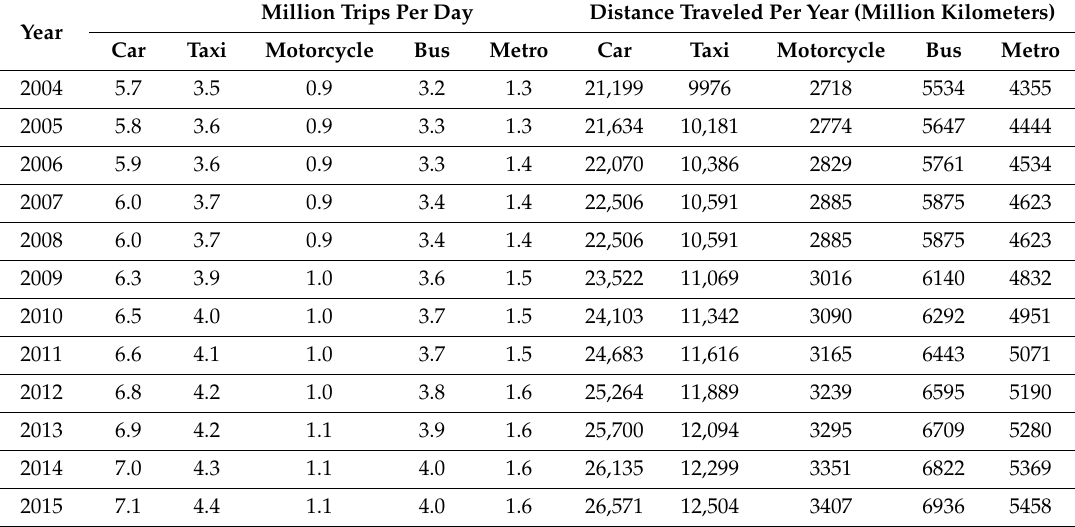
Table 3. Daily trips and distance traveled by each mode of transport in Tehran [52].